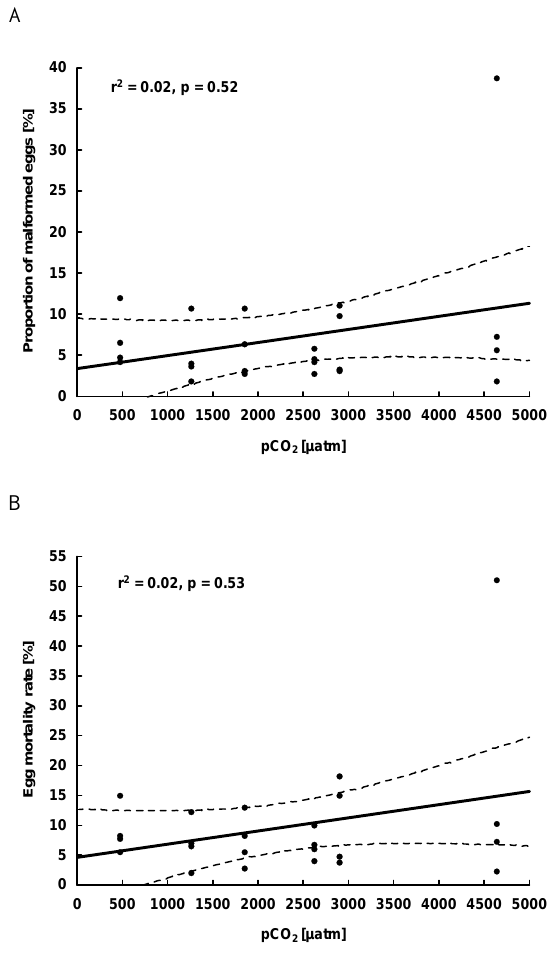
Fig. 1. (A) Proportion of malformed eggs and (B) mortality rate dur- ing the embryonic development as a function of p CO 2 (4 replicates Figure 1. (A) Proportion of malformed eggs and (B) mortality rate during the embryonic development per treatment level). Data points are percentages of malformed eggs as a function of pCO 2 (4 replicates per treatment level). Data points are percentages of malformed eggs and mortality rates, respectively, of incubation plate 1 of the respec- tive replicate. The solid line shows the regression line, whereas the and mortality rates, respectively, of incubation plate 1 of the respective replicate. The solid line shows dashed lines represent the 95% confidence intervals. The r 2 and the regression line, whereas the dashed lines represent the 95% confidence intervals. The r 2 and P - P -value were derived from log-transformed data. value were derived from log-transformed data.